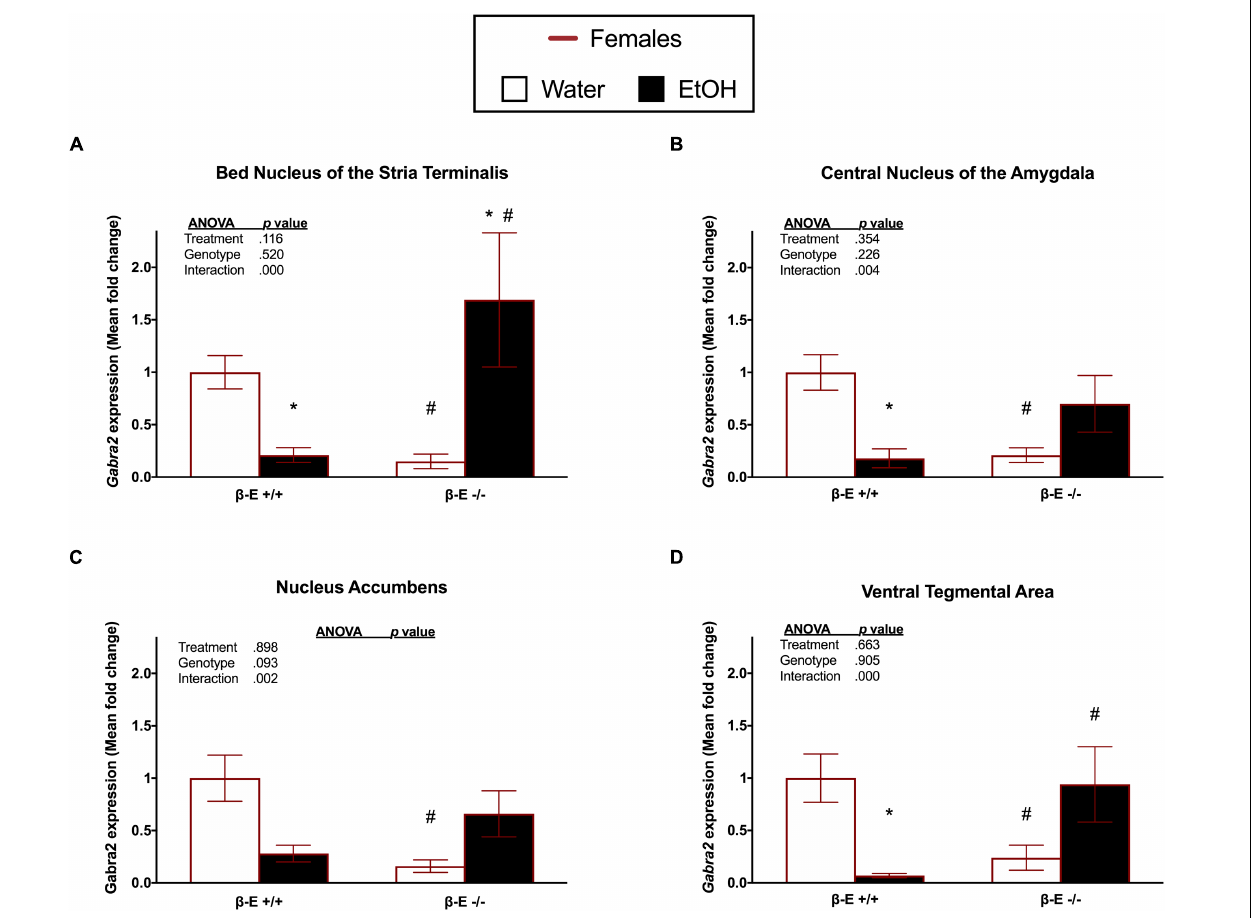
FIGURE 2 | Effects of ethanol on Gabra2 gene expression in stress- and reward-related brain regions of β E +/+ and β E –/– female mice. Gabra2 mRNA expression following binge-like consumption of either EtOH and water or water only in the DID paradigm. Two-way ANOVAs were used to examine the main and interaction effects of genotype ( β E +/+, β E –/–) and treatment (EtOH drinker, water drinkers) in each brain region, results of which are depicted within each graph. (A) In the BNST, post hoc analysis indicated that, under basal conditions (water drinkers), β E –/– females have less Gabra2 expression, relative to β E +/+ females. Further, EtOH consumption reduced Gabra2 expression in β E +/+ females, but increased expression in β E –/– females, such that β E –/– females exhibited higher Gabra2 expression than β E +/+ females who engaged in binge-like EtOH consumption. (B) In the CeA, post hoc analysis indicated that, under basal conditions, β E –/– females have lower Gabra2 expression, relative to β E +/+ females. Similar to the BNST, EtOH also reduced Gabra2 expression in the CeA of β E +/+ females. (C) In the NAc, post hoc analysis indicated that, under basal conditions, β E –/– females have lower Gabra2 expression, relative to β E +/+ females. (D) In the VTA, post hoc analysis indicated that, under basal conditions, β E –/– females have lower Gabra2 expression, relative to β E +/+ females. Following EtOH consumption, β E +/+ females exhibited lower Gabra2 expression than EtOH-drinking β E –/– females due to an EtOH-induced reduction in Gabra2 in β E +/+ females. ∗ p < 0.05 compared with the water drinkers within the same genotype and # p < 0.05 compared with the β E +/+ genotype group that received the same treatment. Data are presented as means ± SEM; Bonferroni correction for multiple